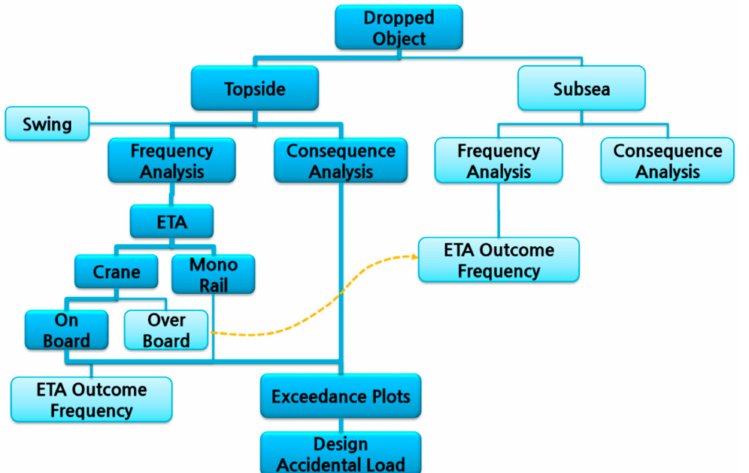
Figure 5. Grand QRA assessment